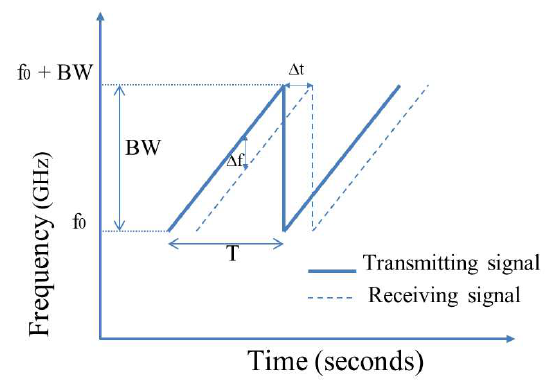
Figure 9. Frequency versus time of transmitting and receiving signal at frequency modulation continuous wave ( FMCW ) radar. BW,